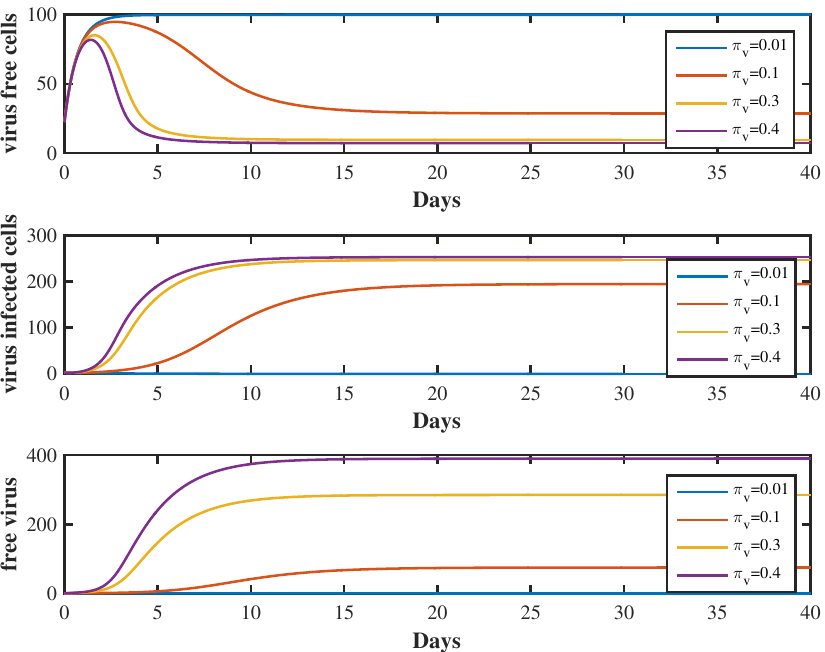
Figure 5. Numerical solution of the model (2) when fixing α = 0.4 and with different π v